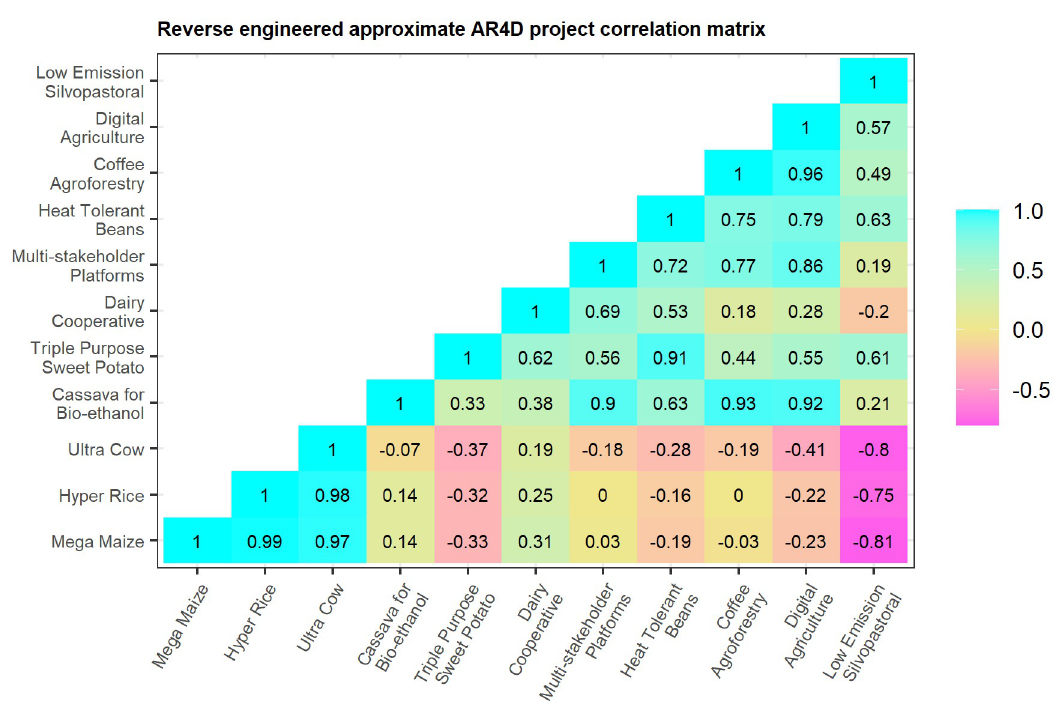
Fig 7. Approximate AR4D project correlation matrix calculated from the crowdsourced policy-project correlations.